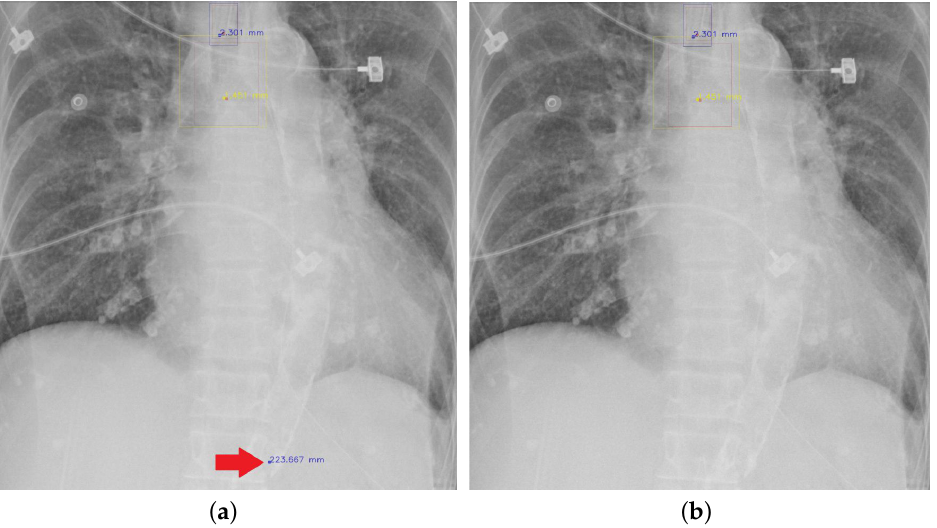
Figure 7. Ensuring at most one ETT tip/Carina left. ( a ) Without post-process. ( b ) With post-process.